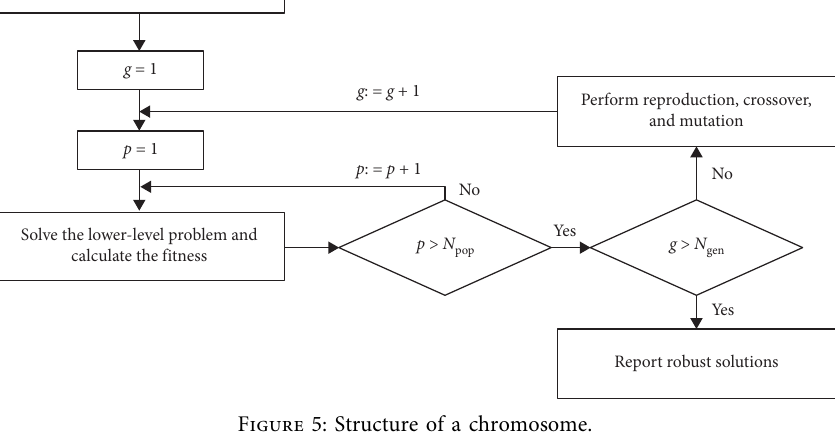
Figure 5: Structure of a chromosome.